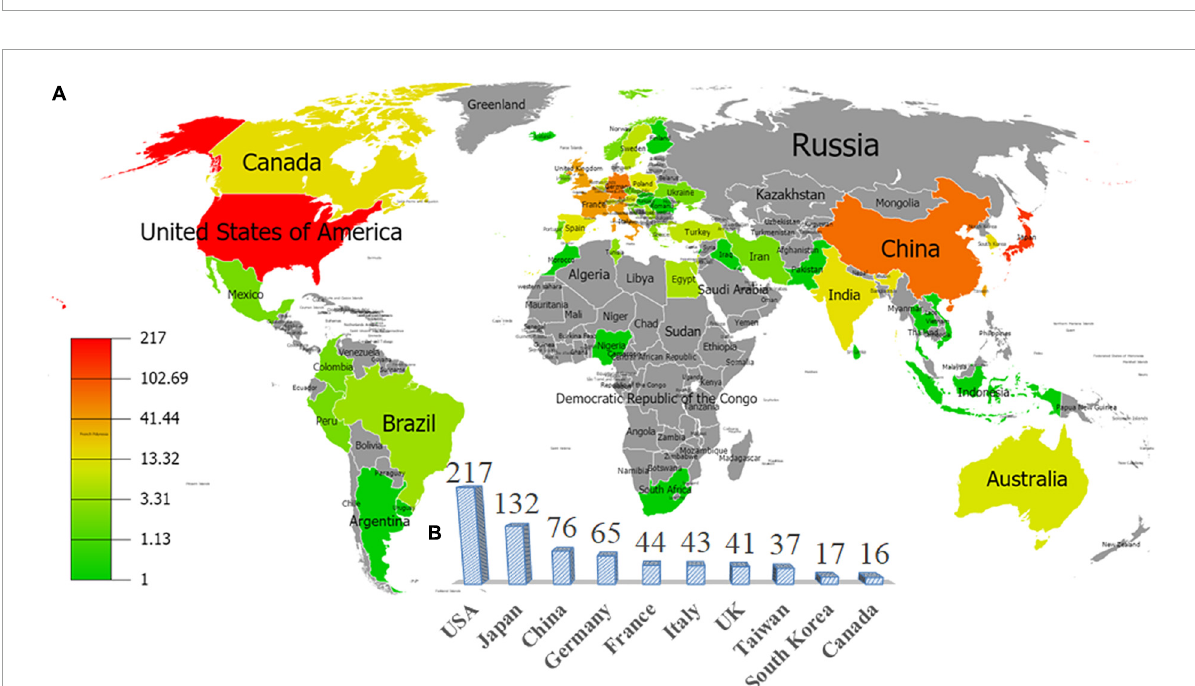
FIGURE3 (A) Global geographic distribution of the total number of documents by country and (B) the top 10 prolific countries based on the number of publications related to “fulminant myocarditis”